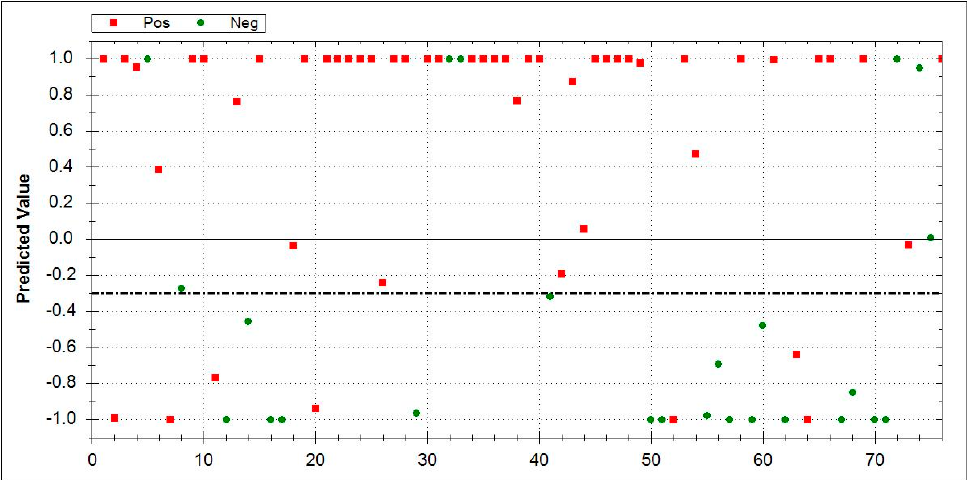
Figure 5. Direct comparison between IPF ( n = 51, red squares) vs. CTD-ILD ( n = 25, green dots). IPF area 0-1: Red squares indicate correctly recognized IPF patients. Green dots denote false positive patients. CT-ILD area 0- -1: Green dots represent correctly identified CTD-ILD, while red squares mark false negative results. The dotted line is inserted around the threshold for uncertain cases and included two patients. Abbreviations: IPF-Idiopathic pulmonary fibrosis, CTD-ILD-connective-tissue diseases- associated ILD, In the analysis between COP ( n = 28) vs. CTD-ILD ( n = 25), an AUC of 0.75, a sensitivity of 0.82,